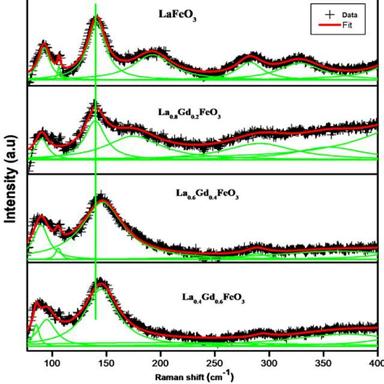
Raman spectra of the Gd doped LaFeO3 multiferroic materials at Room temperature.